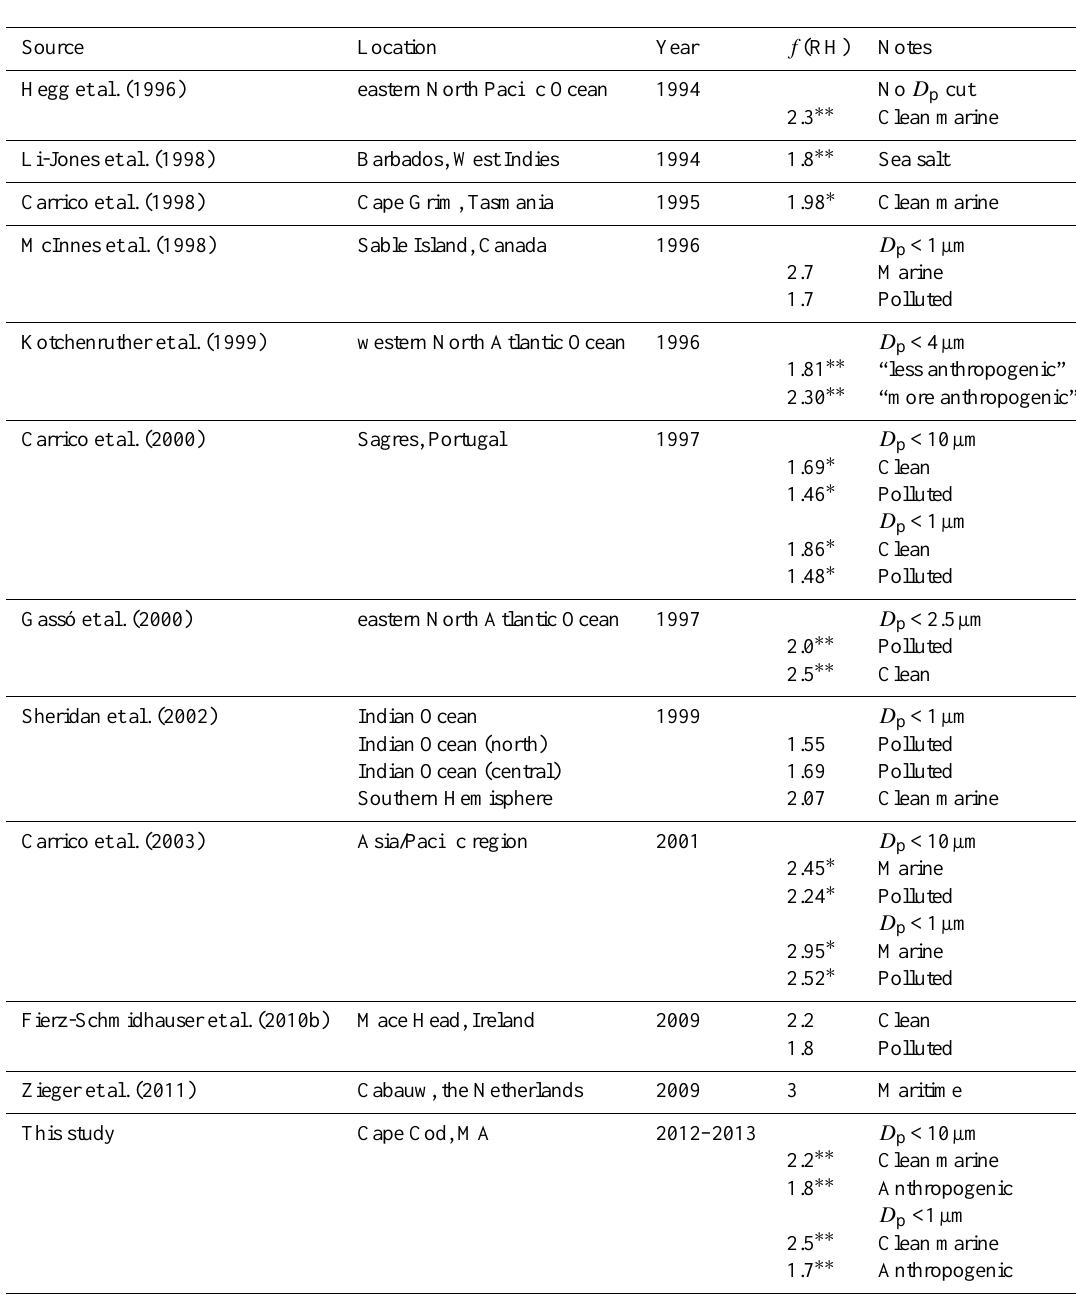
Table 2. Hygroscopic growth factors reported in the literature for marine environments. The values of f (RH) corresponds to the ratio of the aerosol light-scattering coefficients (near 550 nm wavelength) at high RH (85% unless noted: ∗ RH = 82%, ∗∗ RH = 80%) and at dry conditions (RH<40%). All samples were taken with a size cut ( D p ) of 10µm unless specifically